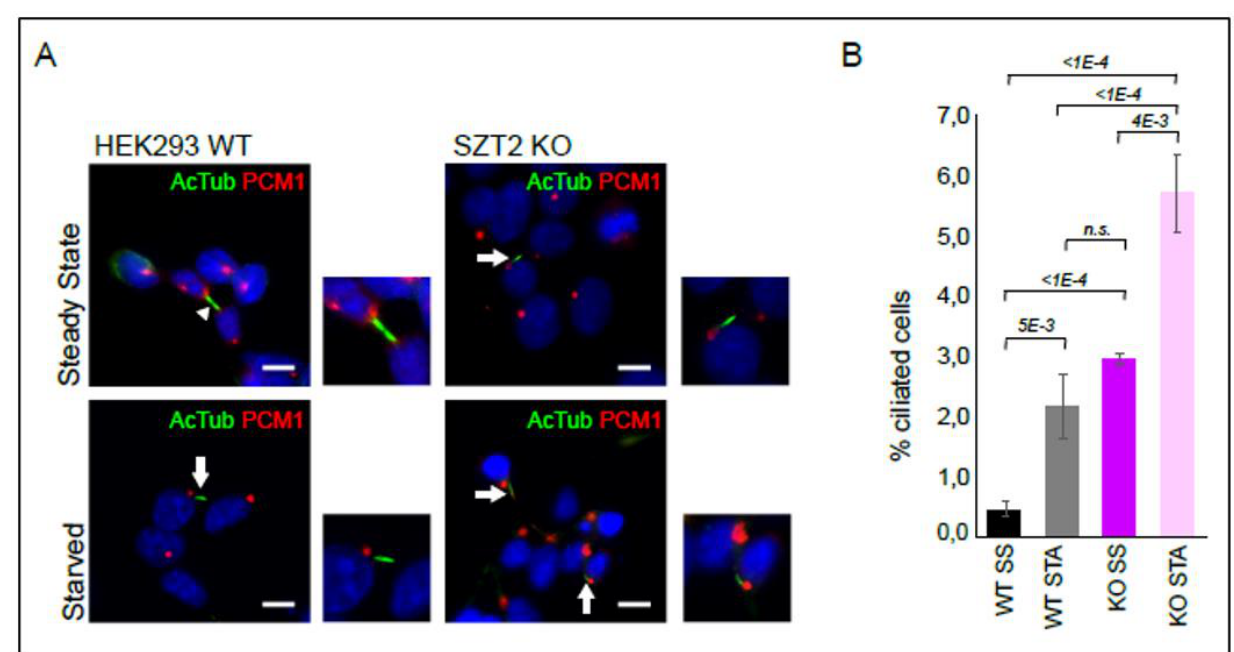
Figure 6. Ciliogenesis in SZT2 KO cells. ( A ) Control Hek293 Flp-In™ T-Rex™ cells and SZT2 KO cl.63 were either left untreated or starved for growth factors for 72 h to induce ciliogenesis. Cells were then fixed and stained with antibodies against acetylated tubulin (green) and PCM1 (red). The nucleus of the cells was counterstained with Hoechst. Arrow head points to a midbody that is also enriched in acetylated tubulin. Arrows indicate cilia. Scale bar 10 µm. ( B ) Quantifications of ( A ) representing the percentage of ciliated cells found in each cell line and condition ± standard dev. Statistical significance was calculated using a nonparametric Kruskal–Wallis test with subsequent Dunn’s test and the italic numbers represent the p -value.